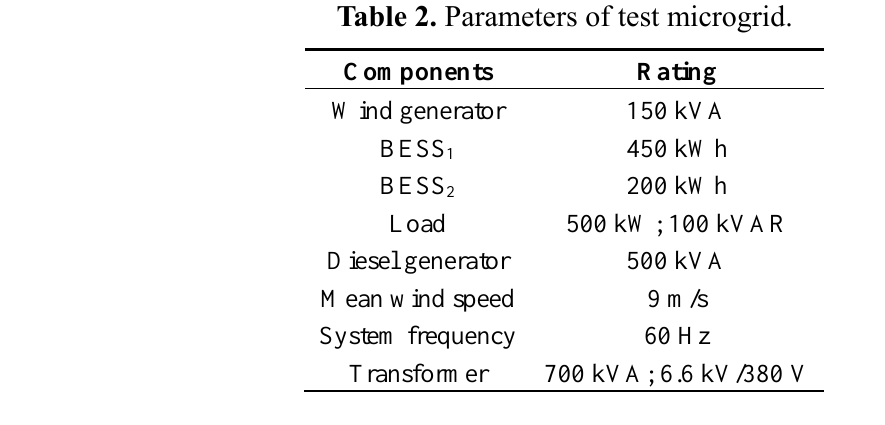
Table 3. Control strategies of